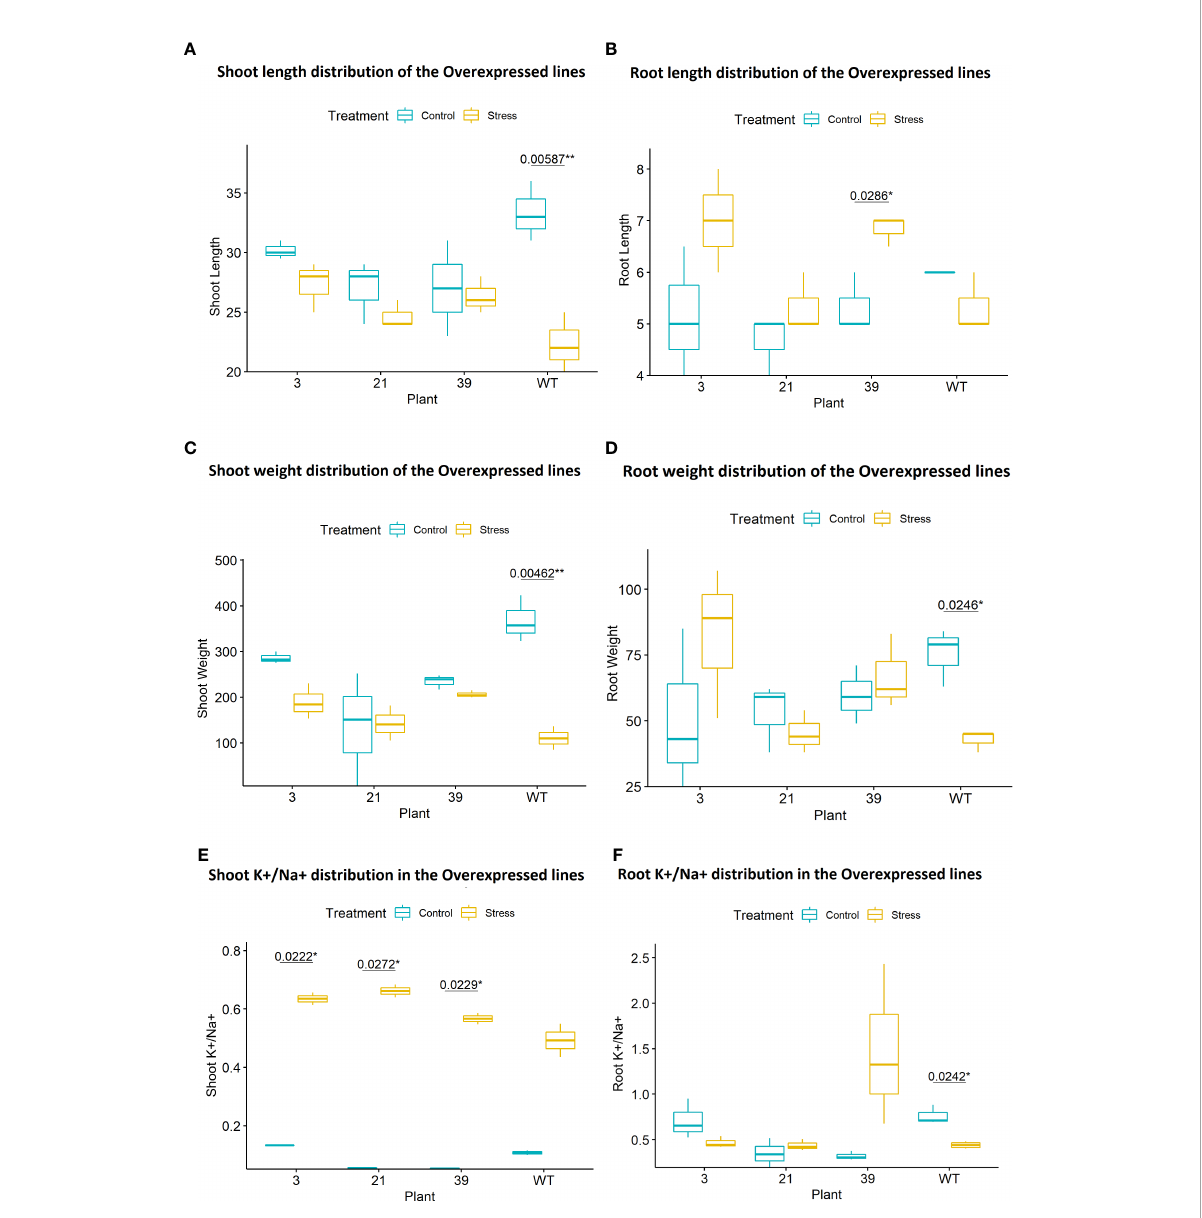
FIGURE 11 (A) Percent Reduction of shoot length was less in the transgenic lines and the wild type plants showed signi fi cantly high reduction (p < 0.01) under stress compared to no stress. (Transgenic lines = 3, 21, 39, WT = Wild Type BRRI dhan28). (B) Percent increase in root length was higher in the transgenic lines and signi fi cantly higher (p < 0.05) in line 39 under salt stress compared to no stress and the wild type plants showed reduction under stress. (Transgenic lines = 3, 21, 39, WT = Wild Type BRRI dhan28). (C) Percent Reduction of shoot weight was less in the transgenic lines and the wild type plants showed signi fi cantly high (p<0.01) reduction under stress compared to without stress condition. (Transgenic lines = 3, 21, 39, WT = Wild Type BRRI dhan28). (D) Percent reduction in root weight was less in the transgenic lines and the wild type plants under 120 mM salt stress showed signi fi cant reduction (p < 0.05) compared to without stress condition. (Transgenic lines = 3, 21, 39, WT = Wild Type BRRI dhan28). (E) Signi fi cant increase ( p < 0.05) in K+/Na+ ratio was observed in the shoot tissues of transgenic lines 3, 21 and 39 under salt stress compared to their without stress condition which was not observed in the wildtype. (F) Signi fi cant decrease (p < 0.05) in K+/Na+ ratio was observed in root in the wild type compared to no stress. Transgenic line 39 showed higher increase under salt stress. (Transgenic lines = 3, 21, 39, WT = Wild Type BRRI dhan28). **P < 0.01, *P <